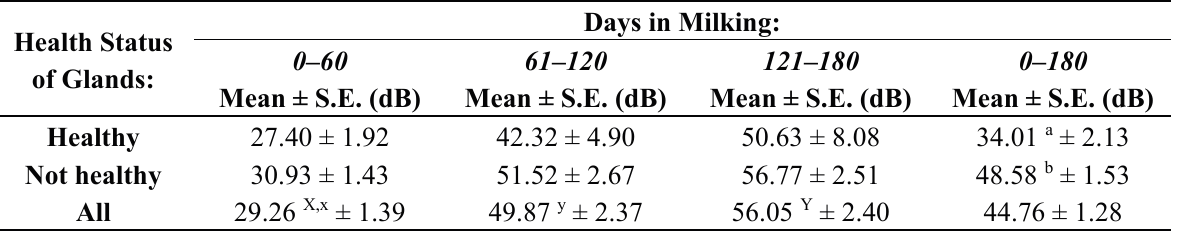
Table 7. Overall means and standard errors of the amplitude of peak FFT_P 1 , according to health status and lactation stages.